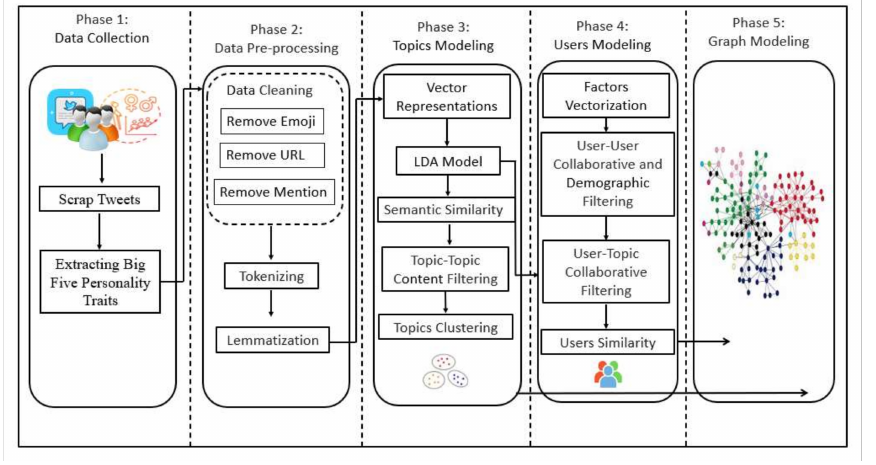
Figure 3. Proposed